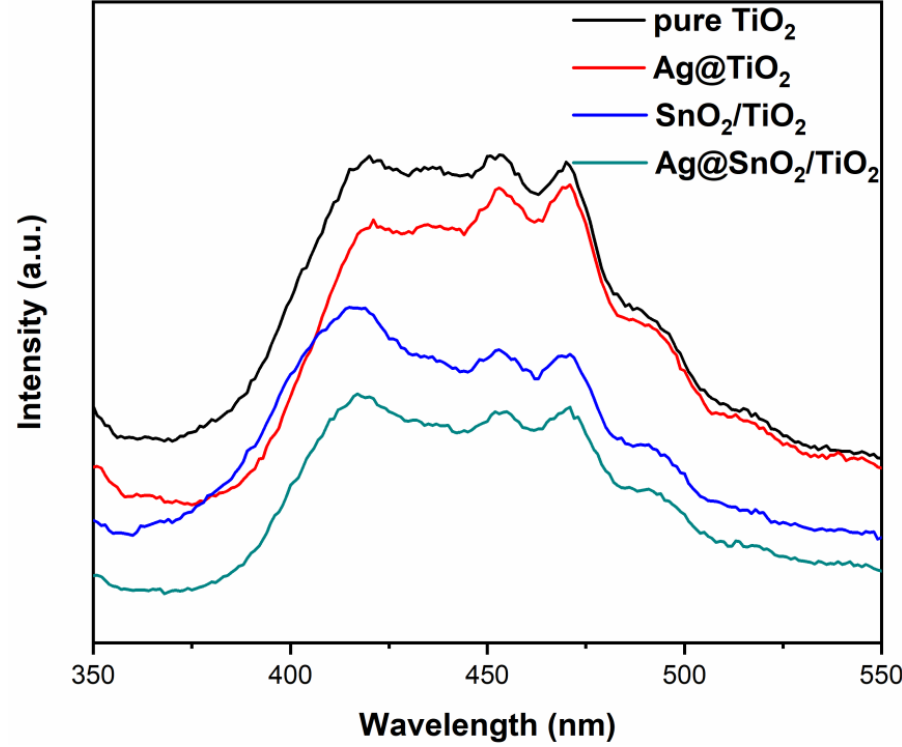
Figure 5. PL spectra of pure TiO 2 , Ag@TiO 2 , SnO 2 /TiO 2 and Ag@SnO 2 /TiO 2 .